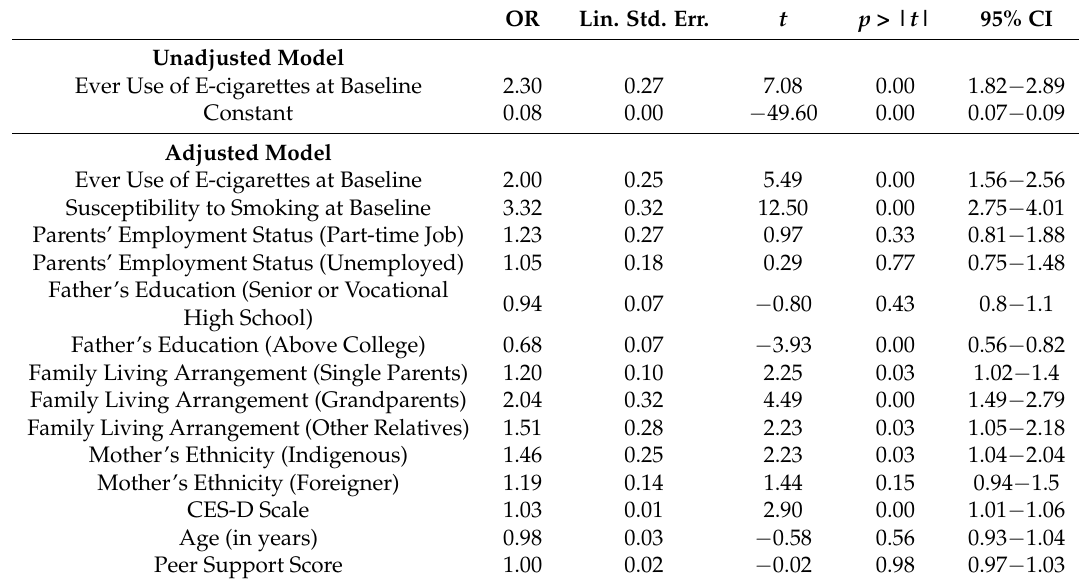
Table A2. Sensitivity Analysis: regression output assuming all the students lost at follow-up were non-smokers—weighted estimates (observations: 12,921).